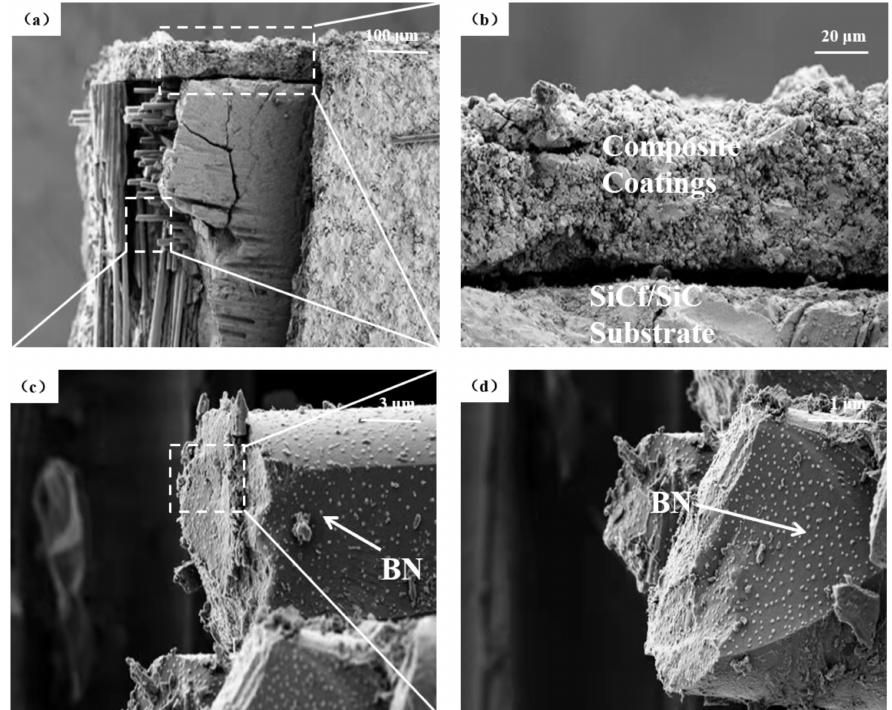
Figure 10. The morphology of the fracture developed under a load of 340 N in a sample held at 766 ◦ C: ( a ) local fracture morphology; ( b ) local interface between the coating and substrate after fracture; ( c ) fracture features of a matrix fiber; and ( d ) enlarged view of the fracture surface of the matrix